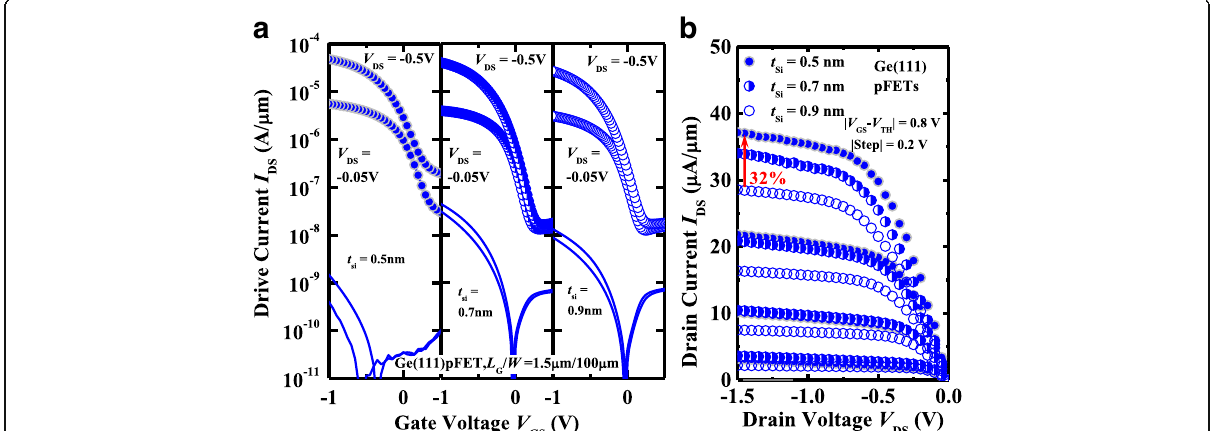
Fig. 7 a I DS - V GS and I G - V GS and b I DS - V DS curves of Ge(111) pMOSFETs with various t Si . Transistor with 0.5 nm t Si exhibits a 32% improvement in I ON compared to the device with 0.9 nm